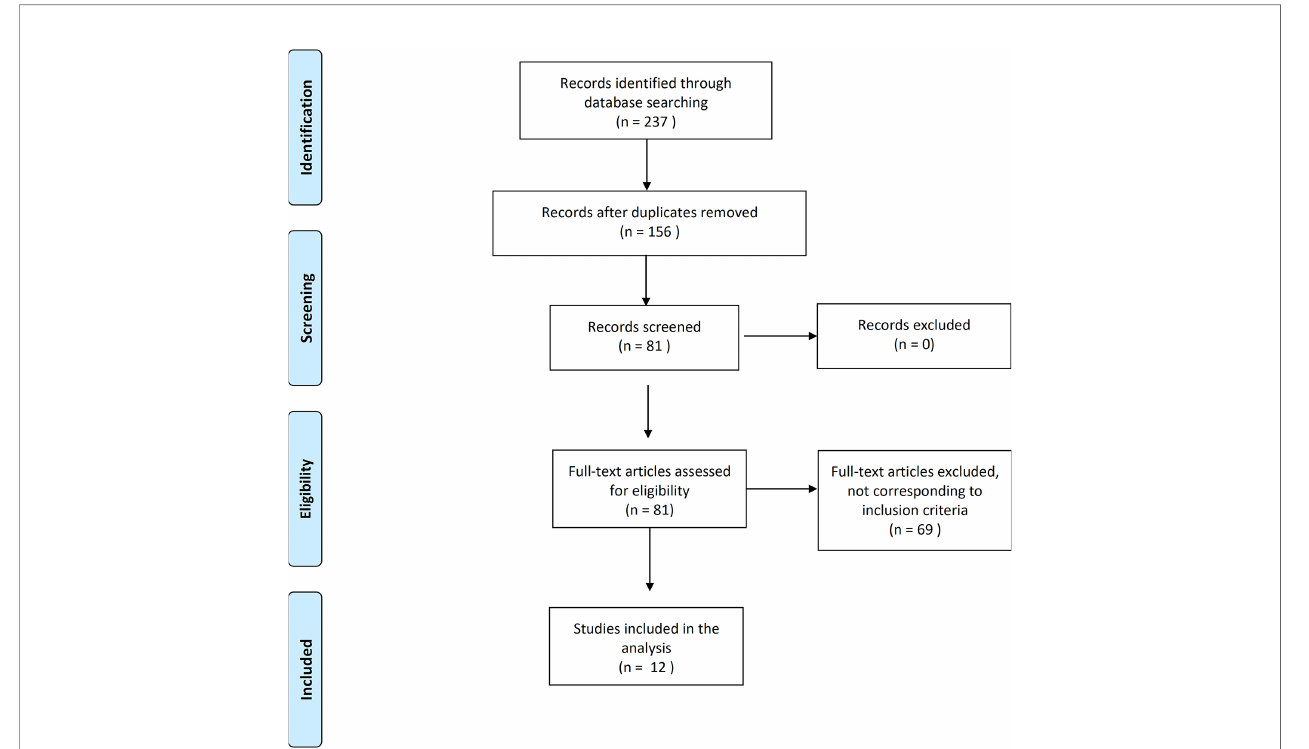
FIGURE 1 | Results of the screening